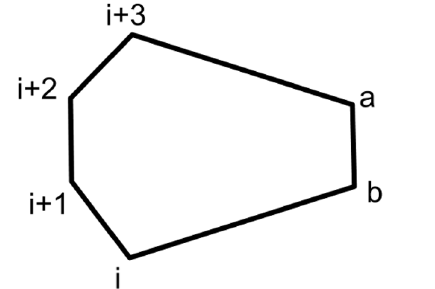
Figure 5 . The hexagon carved out by a collection of diagonals corresponding to facets in S